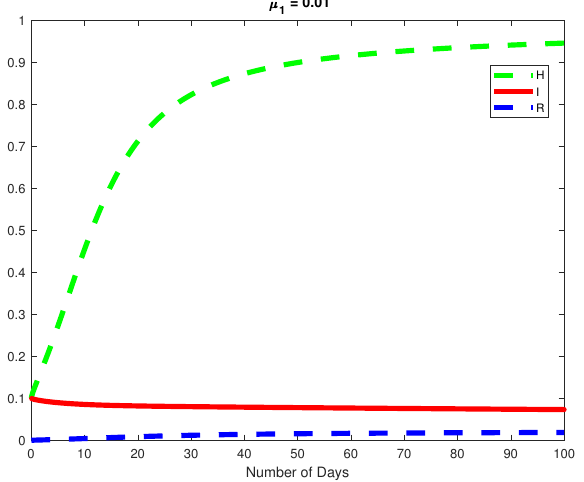
Figure 17. The dynamics of the model for µ 1 = 0.01 at a fractional order of α =